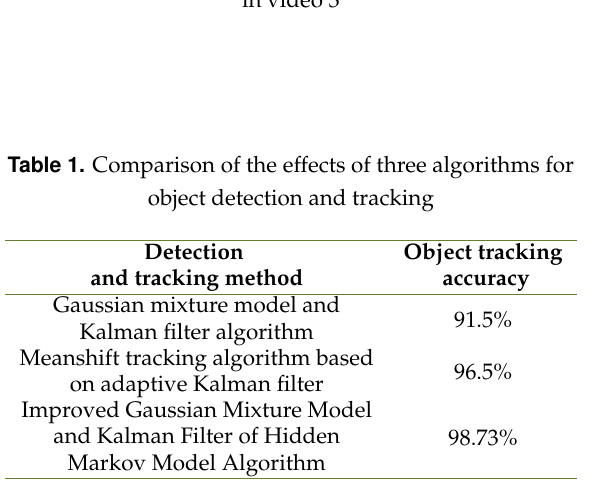
Fig. 19. The average pixel error of the three algorithms in video 3